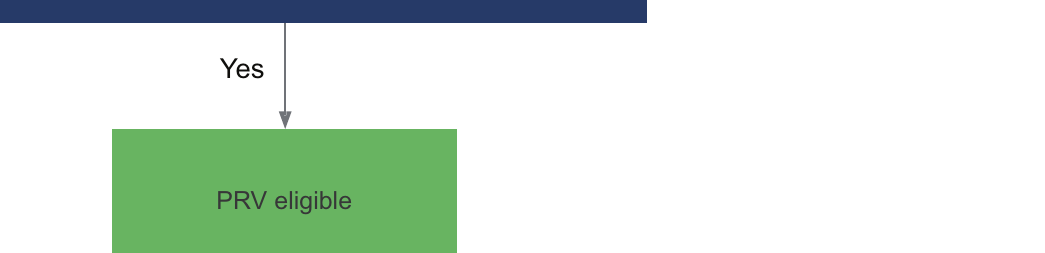
Figure 1. Eligibility decision tree for a US FDA priority review voucher. Criteria are based on the FDA Draft Guidance for Industry: Tropical Disease Priority Review Vouchers.